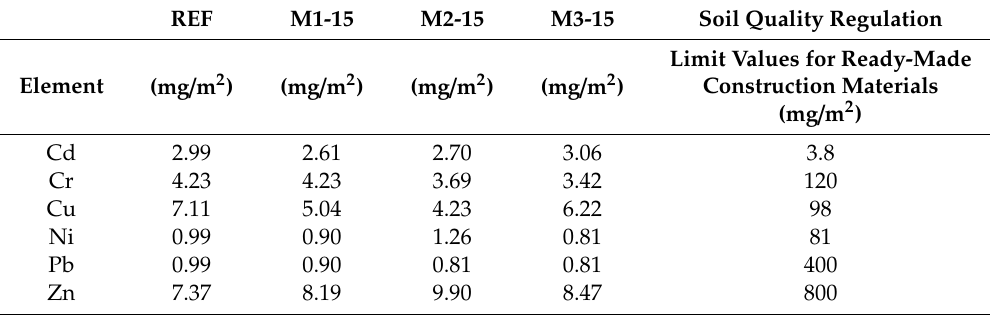
Table 7. Values of cumulative leaching in mg / m 2 for mixtures REF, M1-15, M2-15 and M3-15 after 64 days, and the limit values for cumulative leaching per